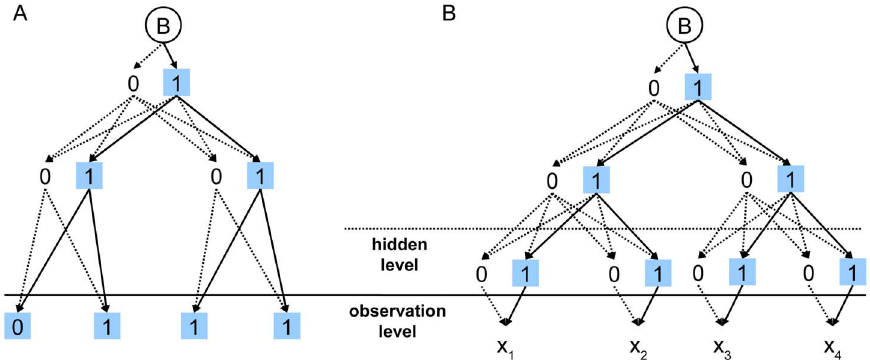
Figure 1. Models for the ancestral state reconstruction. 0 and 1 are two possible states at the tree nodes. The solid edges reflect transitions for the optimal states assignment; the dotted edges are non-optimal edges. The blue boxes denote optimal states at the nodes. B is the start point. ( a ) The discrete state model with observable states at the leaves; ( b ) the HMM model with observable scores and a hidden layer of states at the leaves. Note that in (b) optimal states at the leaves are chosen from the full set of states, while in (a) they are fixed to observable states.